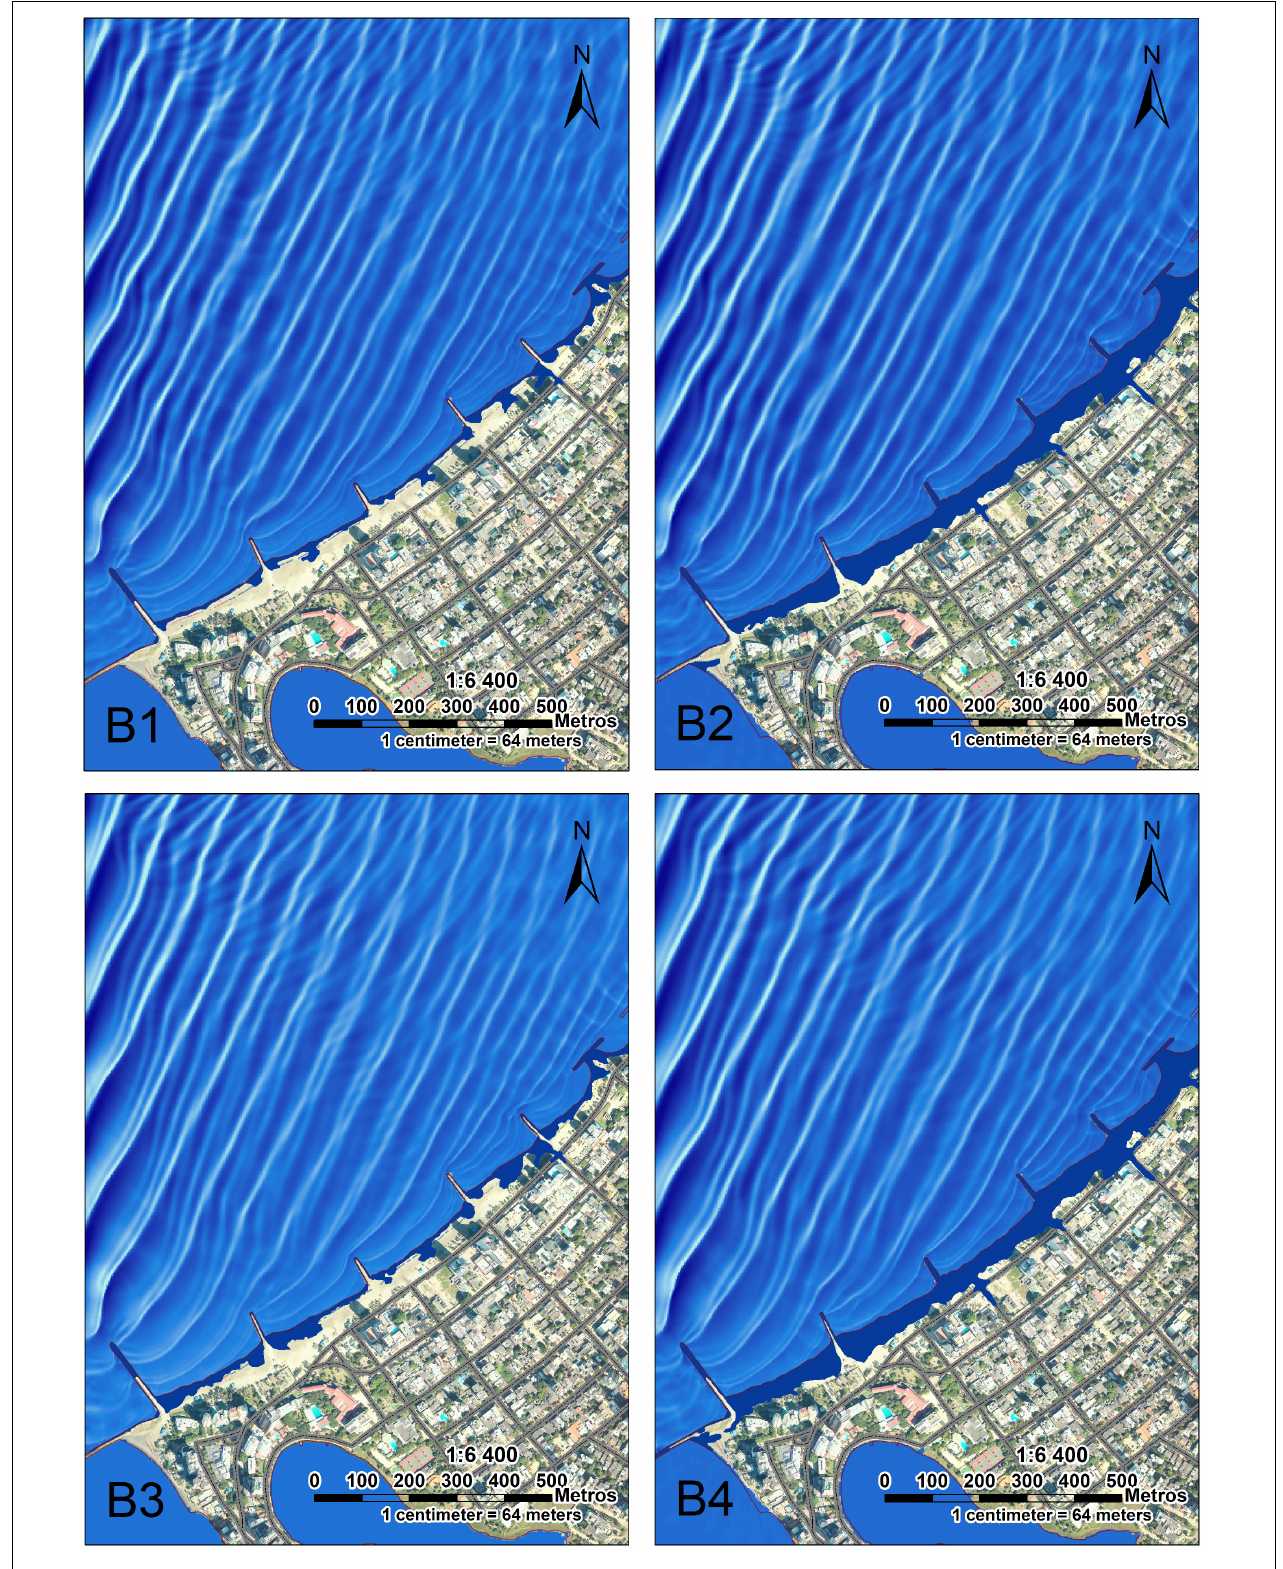
FIGURE 8 | Flooded area generated by cases under present-day conditions and NW coming waves ( B1–B4 , Table 3 ).